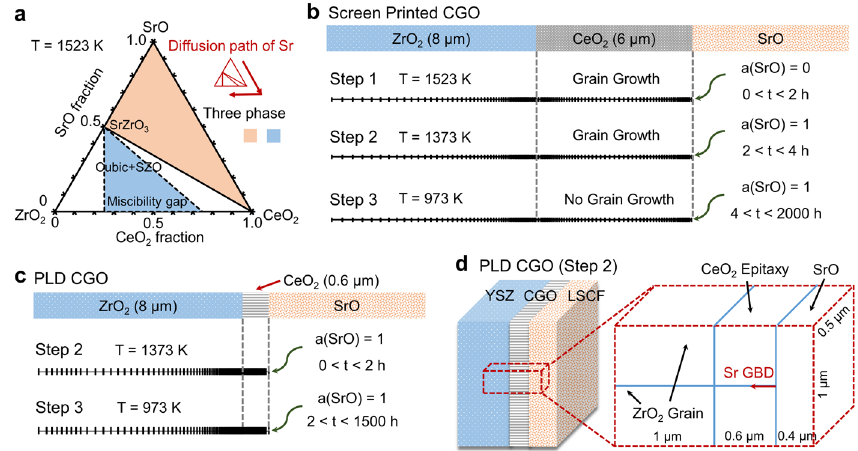
Fig. 8 Models developed for simulating the oxygen electrode – electrolyte interface reactions. a Calculated isothermal section of the ZrO 2 – CeO 2 – SrO system at 1523 K. b 1D numerical model for the simulation of the ZrO 2 – CeO 2 – SrO system in the case of screen-printed CGO barrier layer. c 1D numerical model for the simulation of the ZrO 2 -CeO 2 -SrO system in the case of PLD CGO barrier layer. d Numerical model for 3D phase- fi eld simulation of the SZO formation in the case of PLD CGO barrier layer. For ( b ) and ( c ), the SrO layer is introduced as a virtual layer without thickness. Table 2. The elemental diffusivity data of the current ZrO 2 – CeO 2 – SrO system evaluated based on previous experimental data 42 – 45 . Diffusion